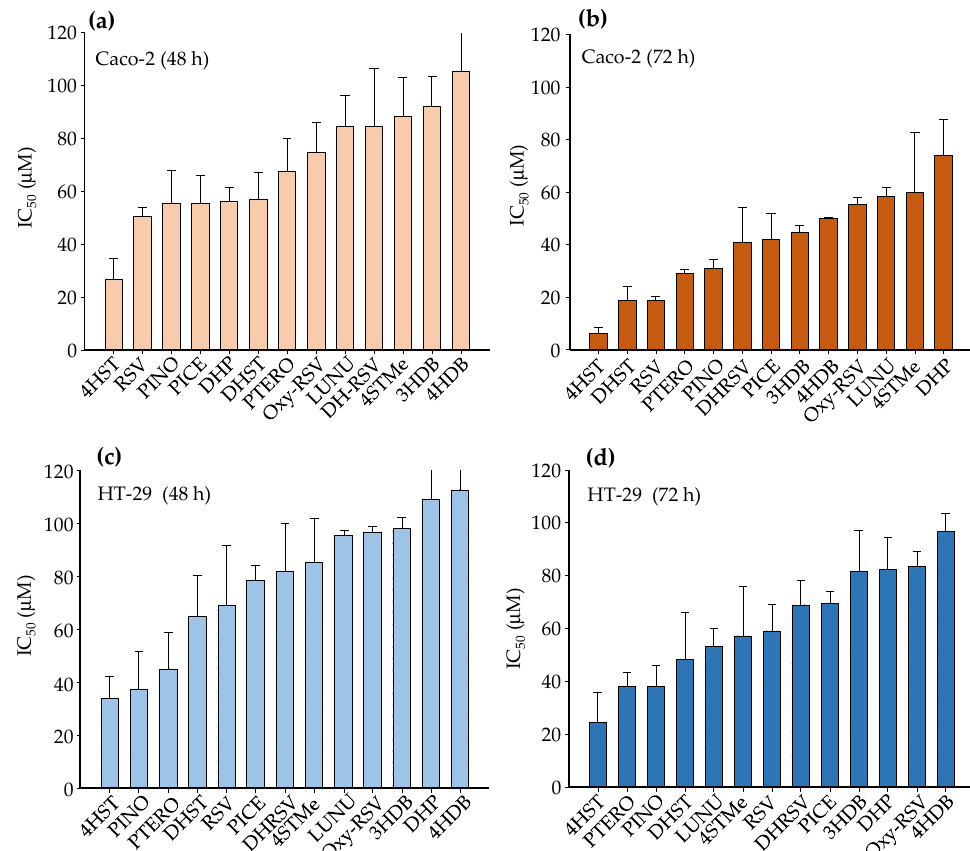
Figure 2. Antiproliferative IC 50 values of stilbenes and dibenzyls in Caco-2 ( a , b ) and HT-29 ( c , d ) cells at 48 and 72 h. Values are shown as mean ± SD (n = 3). Table 1. IC 50 values a ( μ M) at 48 and 72 h in Caco-2 and HT-29 cells.